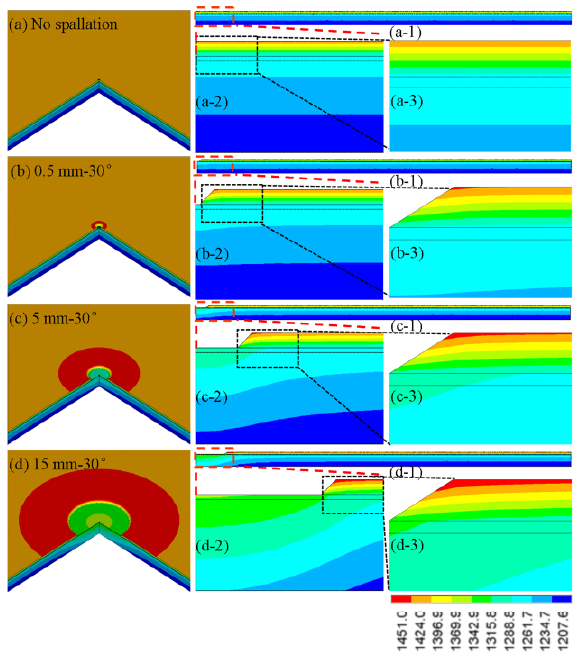
Fig. 3 Temperature distribution under different spallation diameters with a identical tilt angle 30°: (a) 0 mm (no spallation); (b) 0.5 mm; (c) 5 mm; and (d) 15 mm. (a-1)–(d-1) are the 2D temperature distribution corresponding to the model (a)–(d), respectively. (a-2)–(d-2) are detailed indications of the red dashed frame. (a-3)–(d-3) are detailed indications of the black dashed frame.